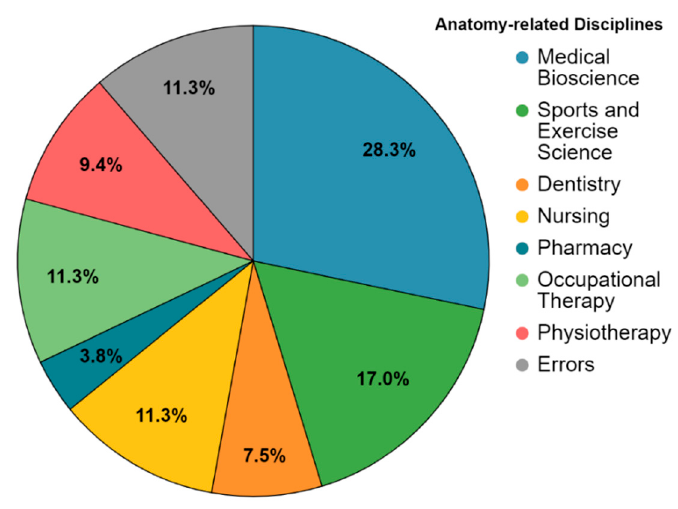
Figure 12. Distribution of participants from various anatomy-related disciplines; “errors” denotes participants with invalid entries for discipline of study.